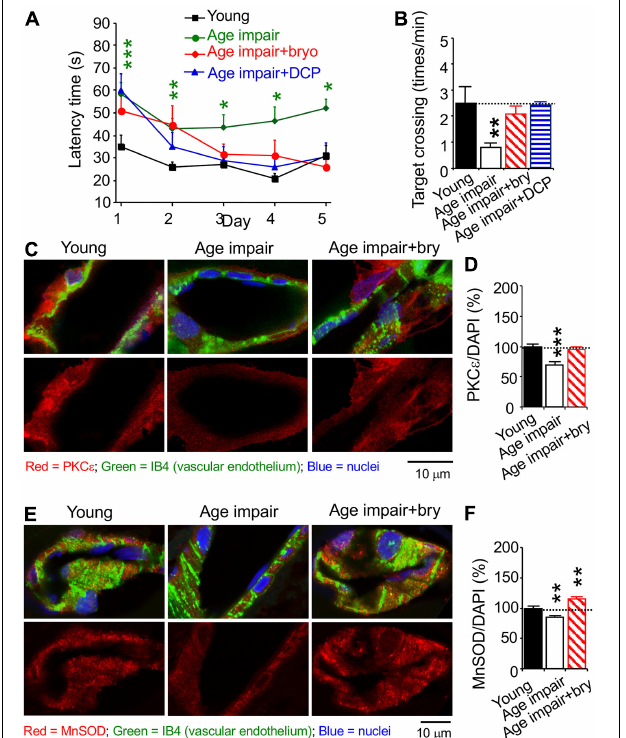
FIGURE 5 | The PKC ε activator prevents spatial memory impairment and a decrease in vascular PKC ε and MnSOD in the CA1 hippocampal stratum radiatum from aged rats. Age-related learning impairment rats ( > 24 months old) were injected with the PKC ε activator bryostatin (bry, 5 µ g/kg body weight) or DCP-LA (DCP, 1.5 mg/kg) diluted with normal saline, i.p., every other day for five injections before and three more injections during spatial memory training, compared to young (5 months old) and aged rats injected with normal saline (in the absence of the PKC ε activator). Rats were trained with water maze to learn to find underwater platform for 5 days (2 swims/day). At 24 h thereafter, memory was determined how rats concentrated on the target area of the removed platform. (A) learning acquisition and (B) memory retention in aged rats, compared to control young rats. The learning and memory defect and MV loss were improved with the PKC ε activator bryostatin and DCP-LA. (C,E) Colocalization of histochemistry of the vascular endothelium marker IB4 and immunohistochemistry was used to determine (D) PKC ε and (F) MnSOD. Data are presented as mean ± SEM; * p < 0.05; ** p < 0.01, *** p < 0.001; one-way ANOVA and post hoc Tukey’s multiple comparison test ( n = 7–15 rats for behavioral study [2 swims/day/rat and 1